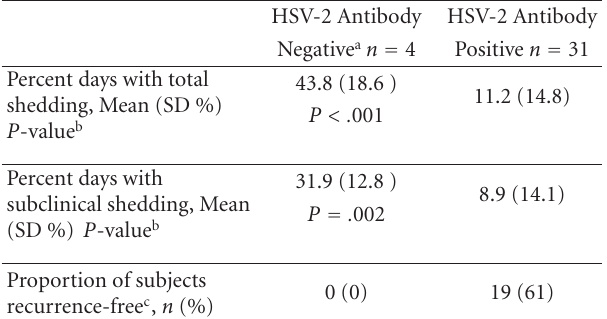
Table 3: Post-hoc Analysis of Patients with Documented Incident Infection—Results from the First Treatment